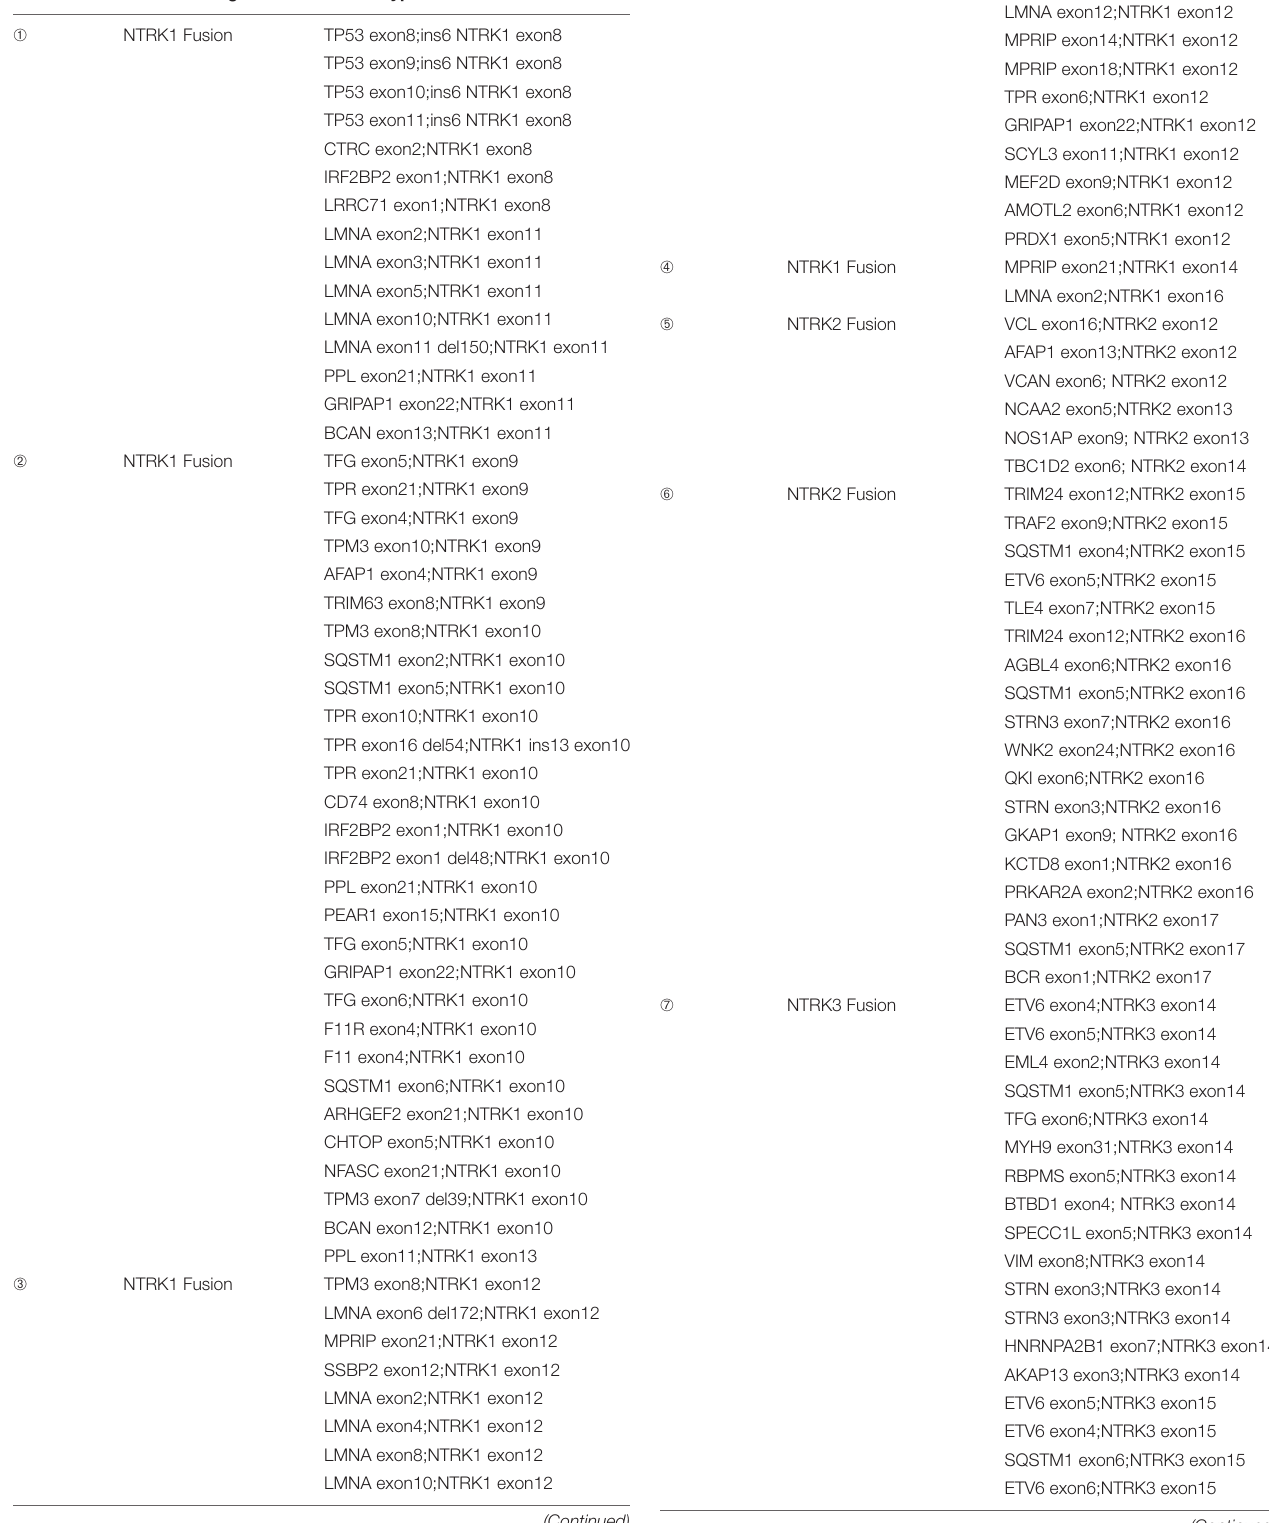
TABLE 1 | The detailed information on the NTRK fusion types examined by the RT-PCR kit.